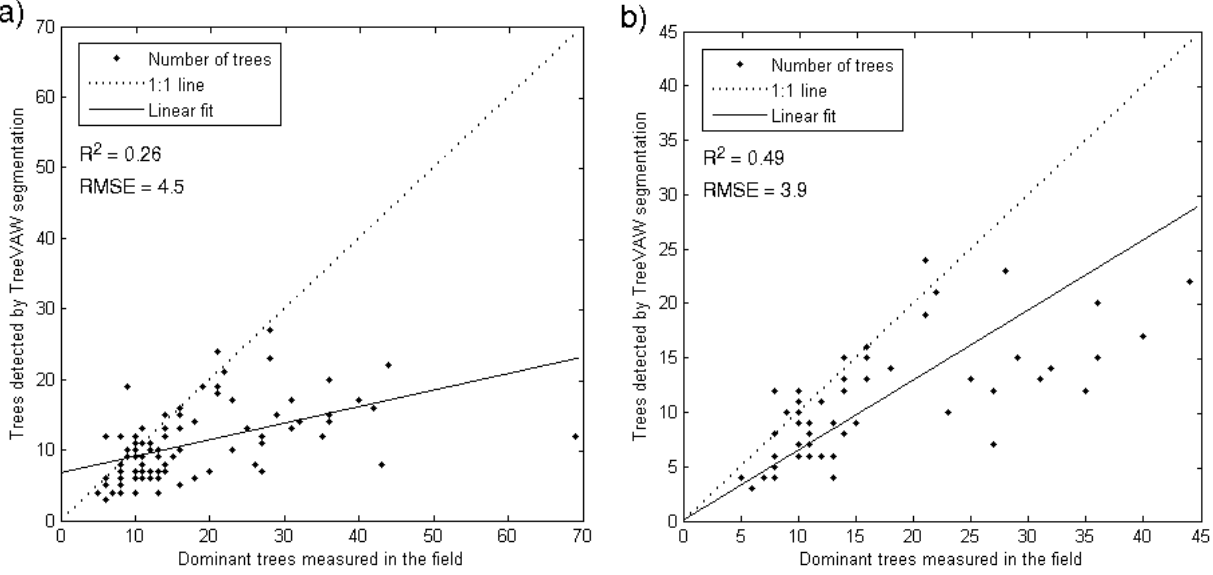
Figure 5. Performance of the TreeVaW tree top detection algorithm applied to ( a ) all plot data; and to ( b ) plots classified as mature forest